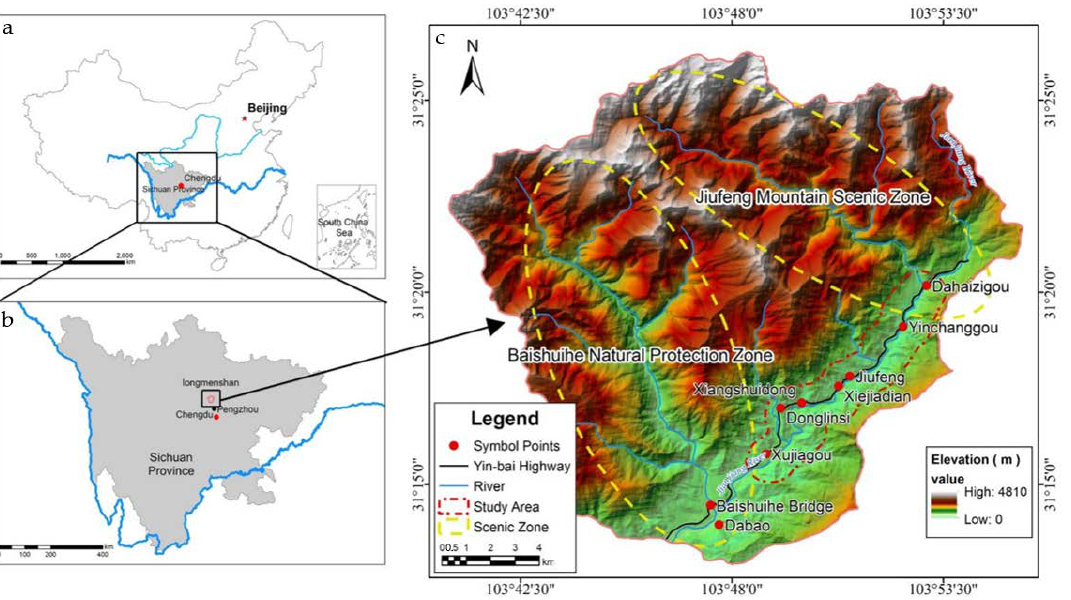
Figure 2. Maps showing the location in ( b ) Sichuan Province of ( a ) China, where ( c ) the study area is